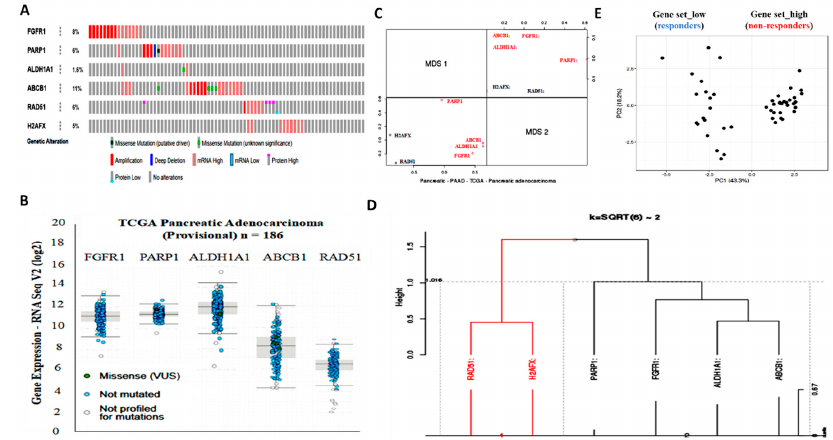
Figure 2. Aberrant FGFR1 and PARP1 expression is associated with cancer stem cell-like phenotype, regulates DNA repair, and modulates response to therapy in PDAC cells. ( A ) Oncoprint analysis of FGFR1, PARP1, ALDH1A1, ABCB1, RAD51, and H2AFX genetic alterations in the provisional TCGA pancreatic adenocarcinoma cohort. ( B ) Expression profile and ( C ) multidimensional scaling correlation matrix with ( D ) k-means clustering of FGFR1, PARP1, ALDH1A1, ABCB1, RAD51, and H2AFX mRNA in the provisional TCGA pancreatic adenocarcinoma cohort. ( E ) Gene-set expression-based cohort stratification into therapy responders and non-responders using the E-GEOD-17891, AFFY_HG_U133_PLUS_2 dataset ( n = 47). Clustering was based on correlation distance and average linkage. Unit variance scaling is applied to rows; Singular-value decomposition with imputation was used for principal component (PC) calculation. X and Y axes show PC 1 and PC 2, which explain 43.3% and 18.2% of the total variance, respectively. Missense (VUS): Missense variants of uncertain